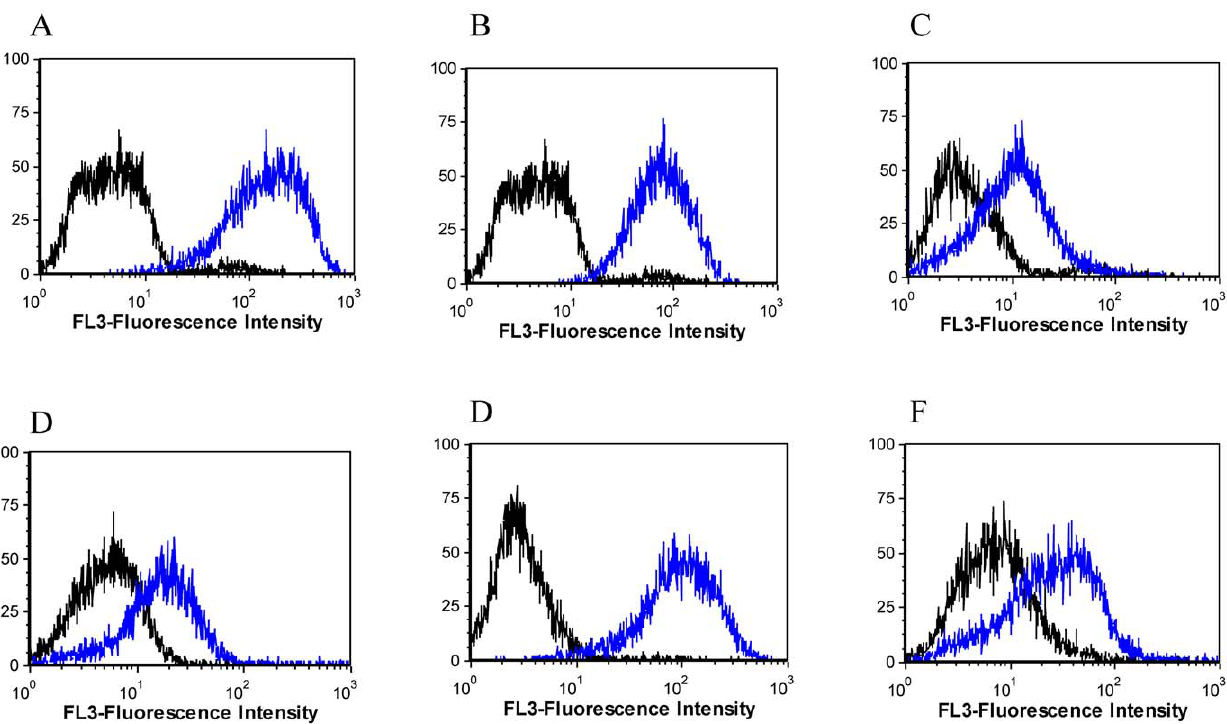
Figure 2. Flow cytometry histograms showing the binding of representative aptamer candidates screened against the target DLD-1 cells. Cells were dissociated with non-enzymatic dissociation solution. The cells were washed and incubated with different aptamer candidates (blue histogram). The fluorescence signal was detected by streptavidin-PE-cy5.5. The unselected library was used as background fluorescence signal (black histogram). All the aptamers A (KDED2), B (KDED5), C (KDED7), D (KDED15), E (KDED19), F (KDED20).